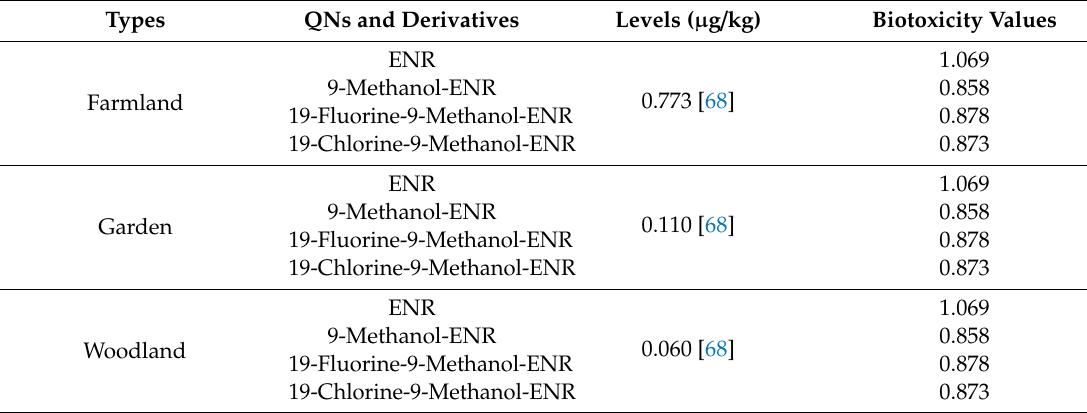
Table 7. QNs concentration and toxicity data in three soil